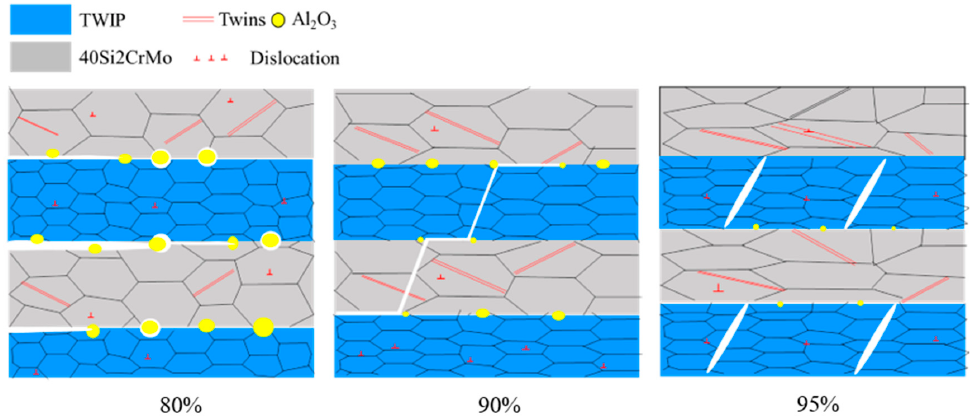
Figure 14. The schematic diagram of damage failure of multilayer steels with different hot rolling reductions.